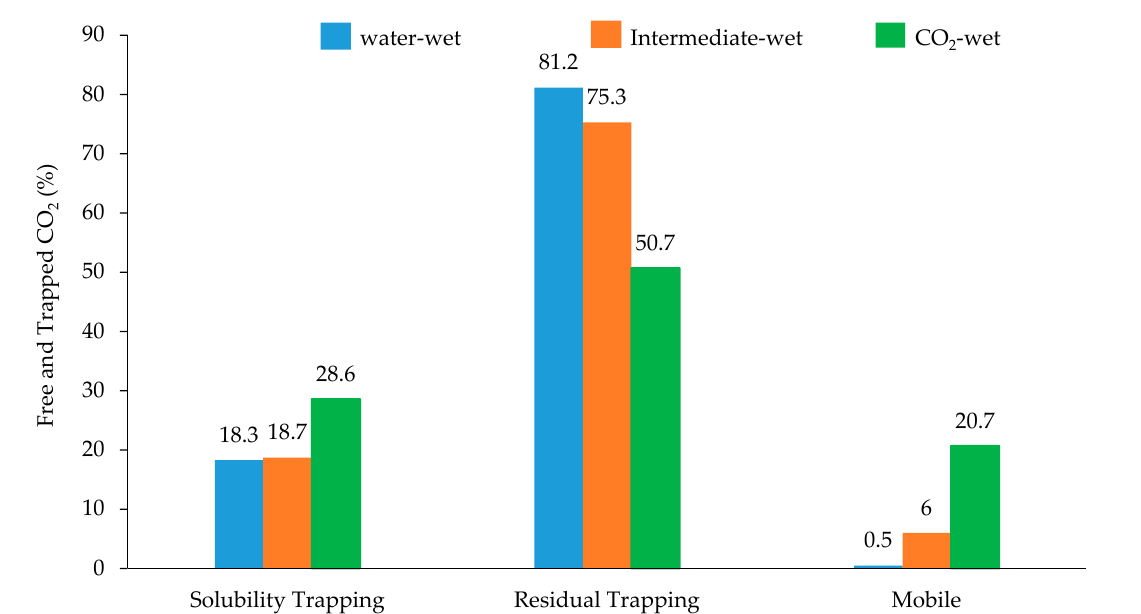
Figure 8. Percentages of free and trapped CO 2 capacities for strongly water-wet, intermediate-wet, and strongly CO 2 -wet rocks (modified from [71]).